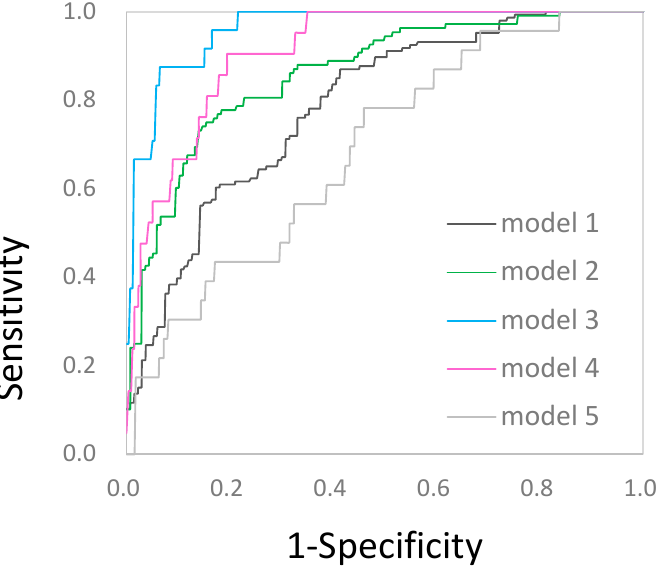
Figure 5. ROC curve. In the Bayesian network approach, the predictive performance (threshold = .85) of Model 3 and 4 are excellent and Model 2 is good.